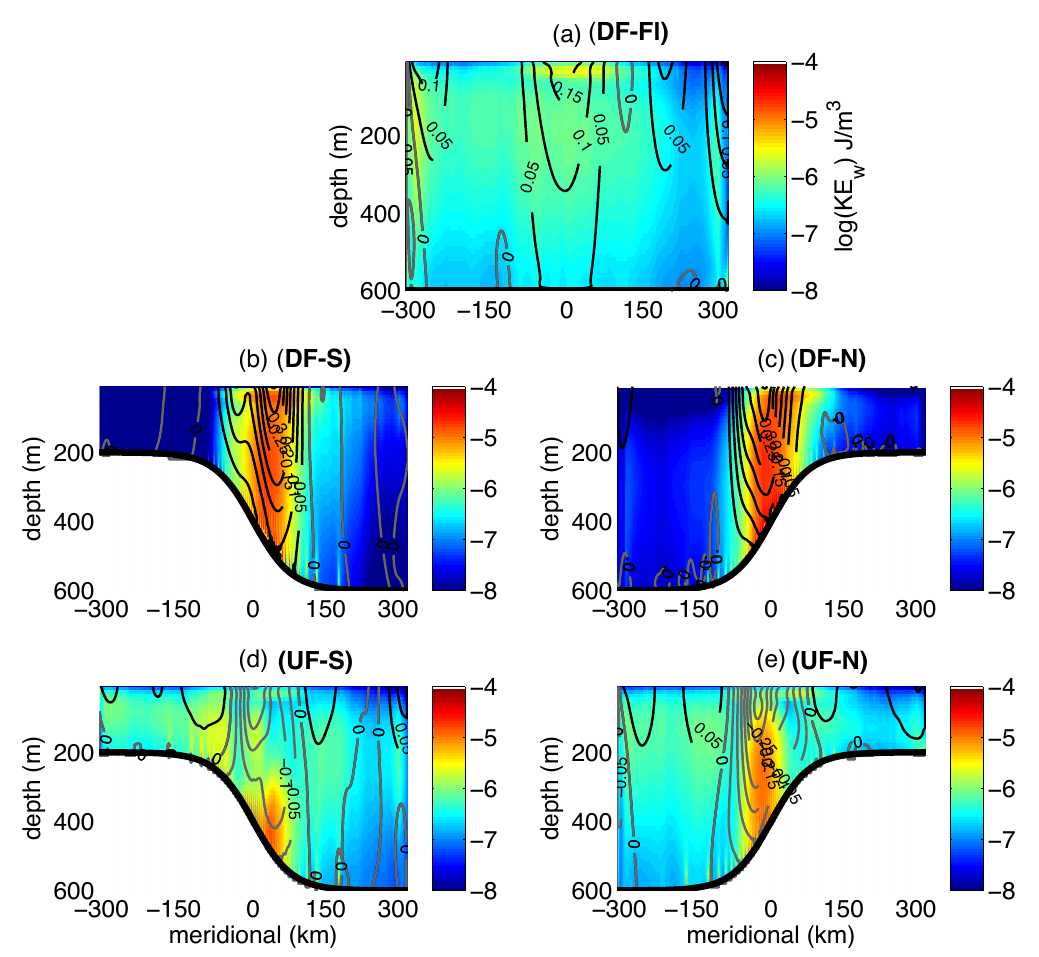
x , t Figure 10. Zonal and time averaged vertical kinetic energy ( ρ w 2 /2) from day 800 to 1000 for for five experiments. Values are displayed in log 10 scale. Contour lines show zonal and time averaged zonal velocity ( u ). Black line represents positive values. Gray line represents negative values. Panels ( a – e ) correspond to experiments (1)–(5) described in Table 1, and experiment ID is